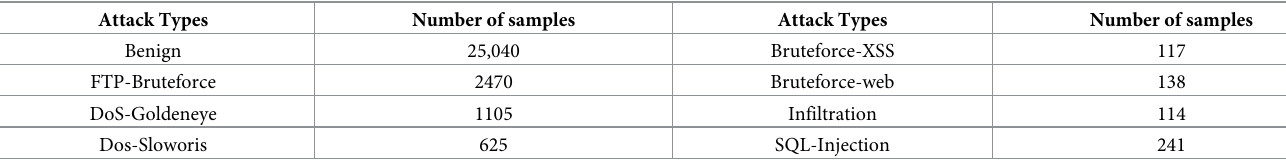
Table 1. The dataset of